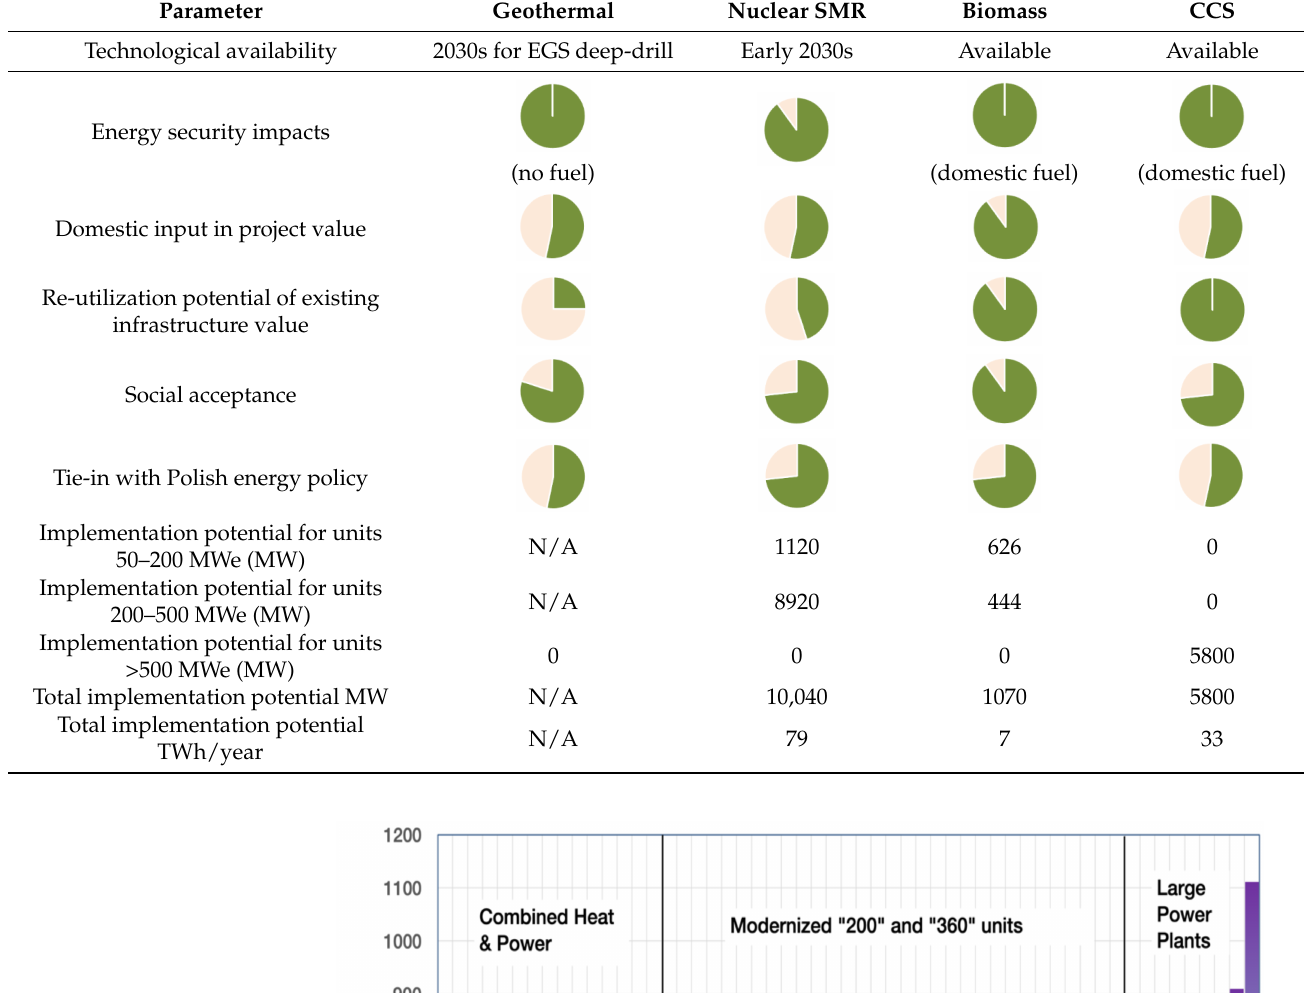
Table 12. Comparison of options for retrofit decarbonization of coal power plants and their scope of potential implementation in Poland.